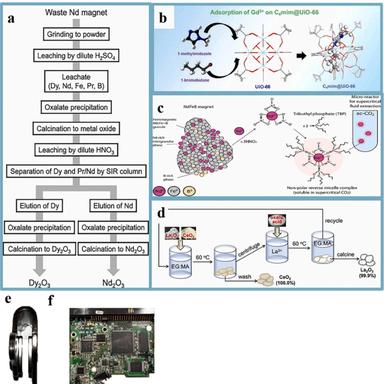
(a) The comprehensive flowchart outlining the recovery process of Dy and Nd from waste Nd magnets. (b) Utilizing UiO-66 coated with ionic liquid to capture Gd3 + in solution (c) Depicting the model for supercritical carbon dioxide (sc-CO2) extraction (d) A schematic representation of the rare earth oxides separation process e) Image of the magnet and f) printed circuit board dismantle from the e-waste.